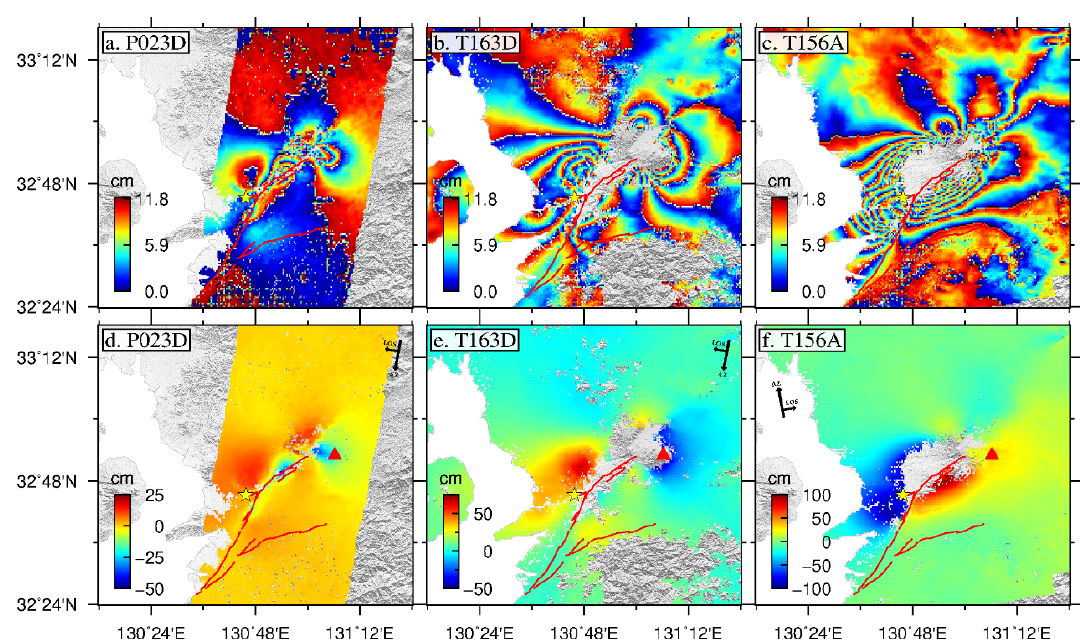
Figure 2. Wrapped and unwrapped InSAR maps. ( a–c ) Coseismic interferograms derived from the ALOS-2 and Sentinel-1A images. Each color cycle represents 11.8 cm of line-of-sight (LOS) deformation. ( d–f ) Unwrapped LOS deformation corresponding to ( a–c ). The active faults are shown as a red line. Yellow star and red triangle denote the mainshock epicenter and Aso volcano, respectively. Positive value indicates LOS displacement moving toward the satellite. Remote Sens. 2020 , 12 , x FOR PEER REVIEW